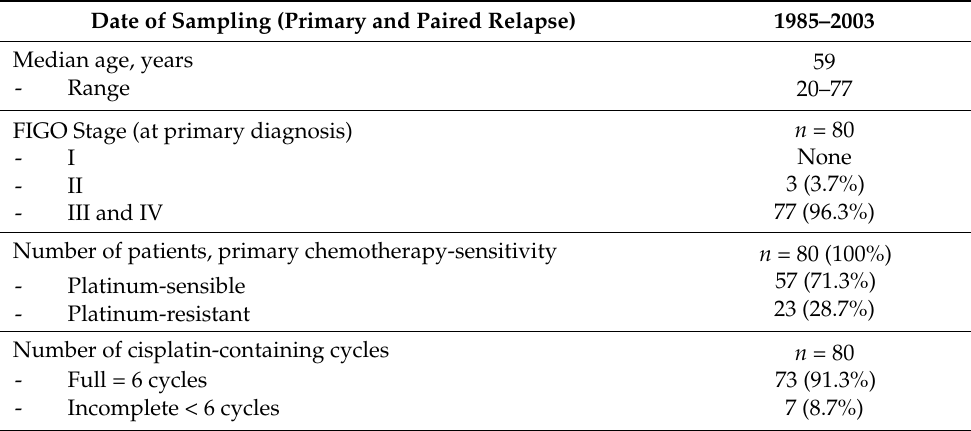
FIGO, Federation of Gynecology and